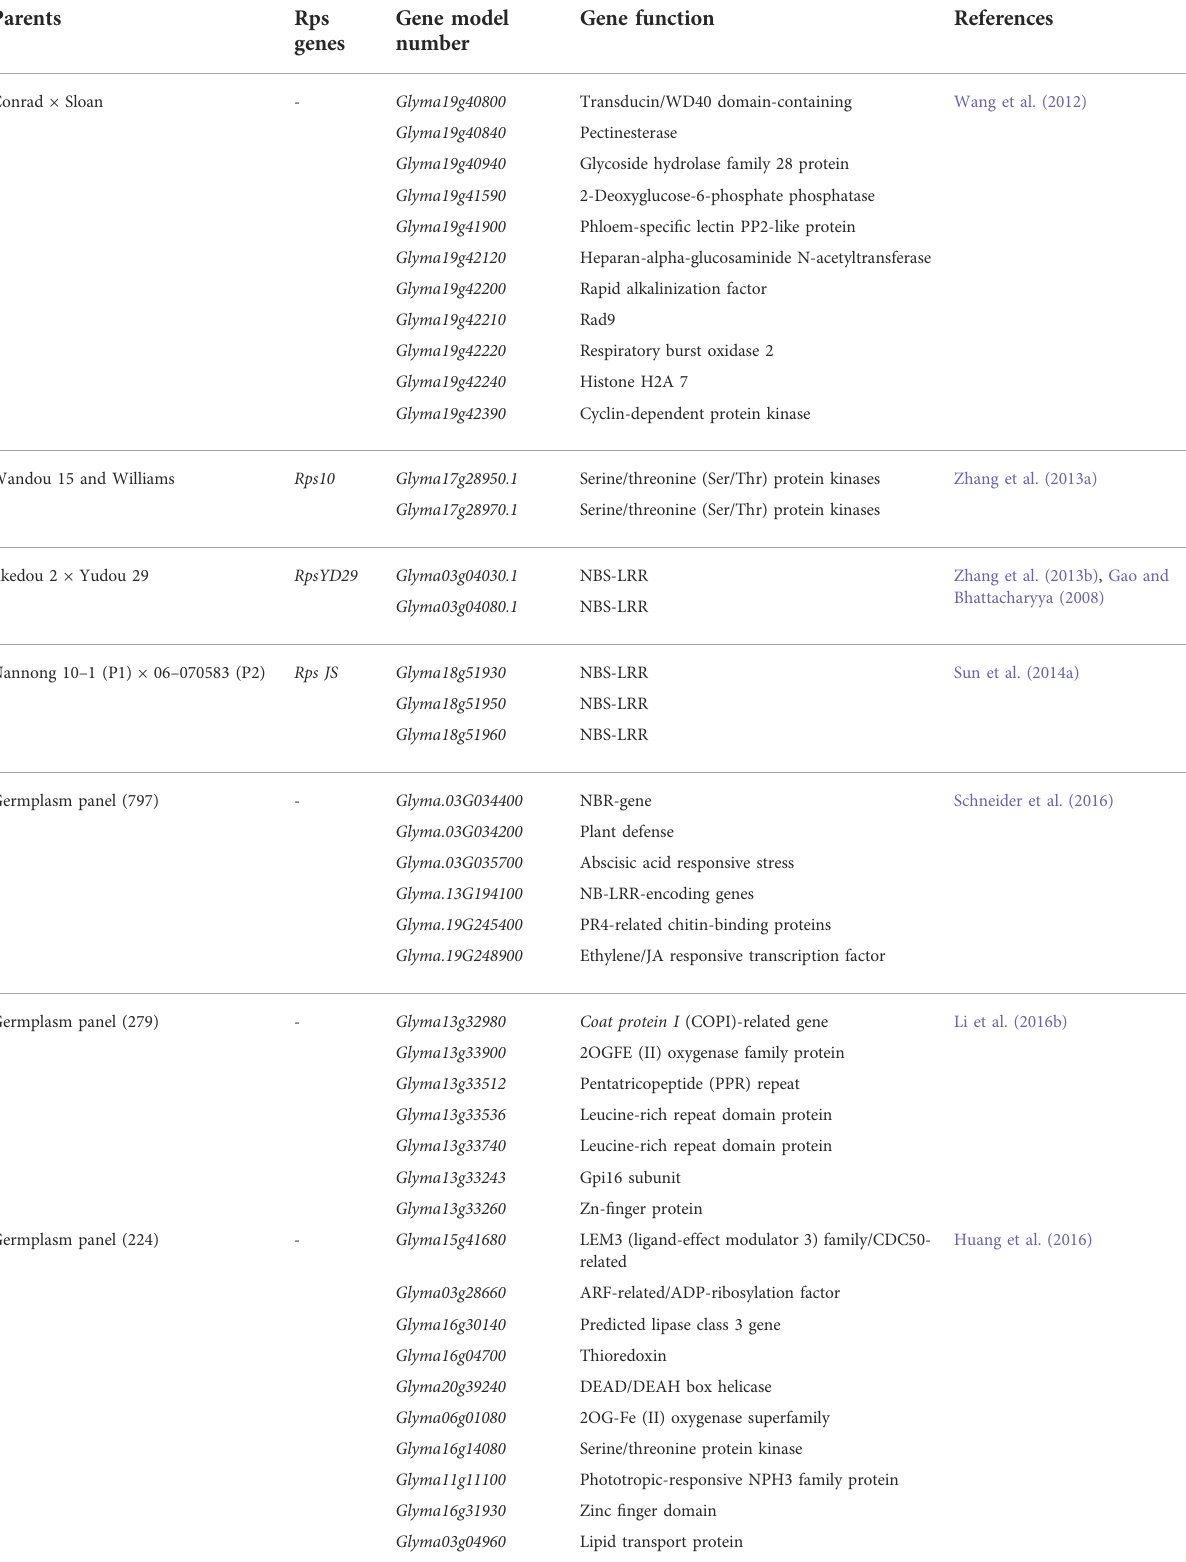
TABLE 4 Putative candidate genes identi fi ed for P. sojae